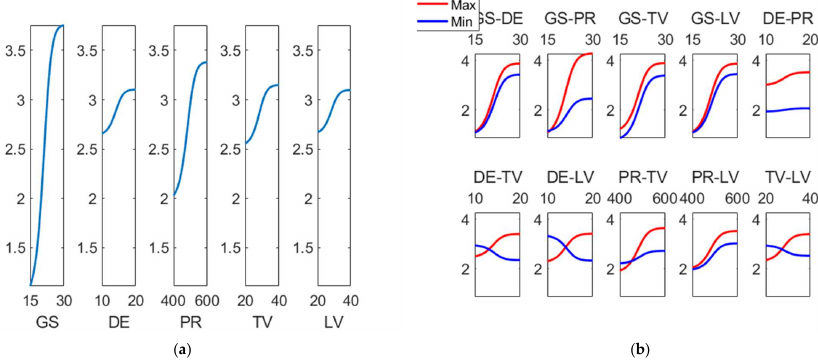
Figure 14. ( a ) Main effects plot and ( b ) interaction effects plot for Rz (µm). Figure 15 corresponds to the main effects plot and the main interactions plot for (Rsk). It can be observed that the main effect for (Rsk) is grain size, followed distantly by pressure. Most significant interactions correspond to those of (GS) with all the other vari- ables. In this work, (Rsk) increases with grain size. Conversely, in the grinding processes of Inconel, (Rsk), a larger grit size results in lower (more negative) (Rsk) values [39]. In polishing operations of copper parts, the corresponding areal skewness parameter (Ssk) decreases slightly with grain size up to a certain grain size value from which it increases [40].